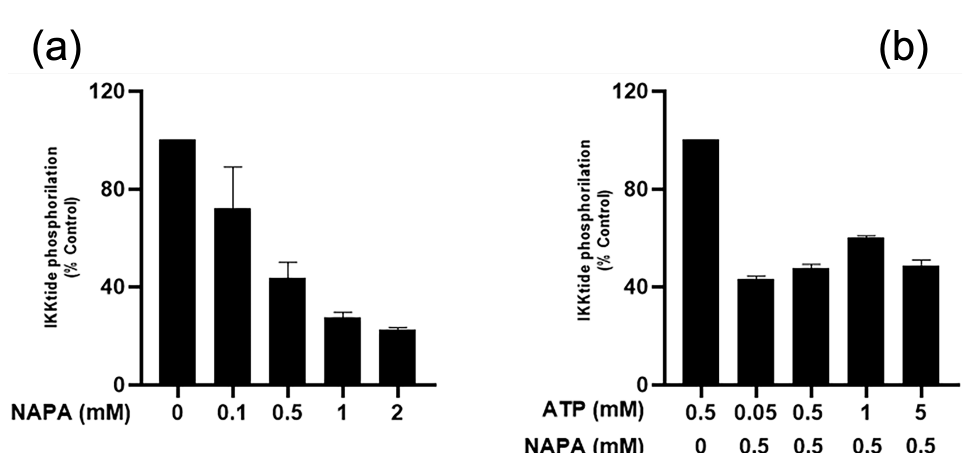
Figure 3. IKKtide phosphorylation inhibition by NAPA. ( a ) The kinase assay was performed as described in the text for 1 h at 30 °C. The NAPA concentrations 0.1 mM, 0.5 mM, 1 mM and 2 mM were used to inhibit the IKK α kinase activity. ( b ) The concentrations of IKK α and NAPA were kept fixed, whereas increasing ATP concentrations were used. The results are reported as mean ± S.E.M. of data obtained by three independent experiments (N = 3). IC 50 was calculated using using GraphPad Prism